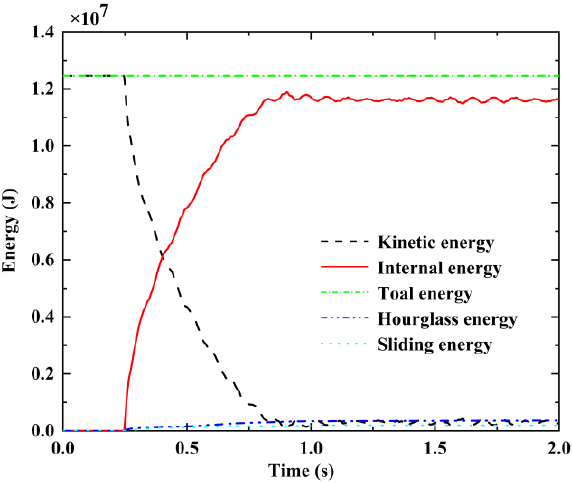
Figure 5. Energy conversion of barge impacting whole bridge